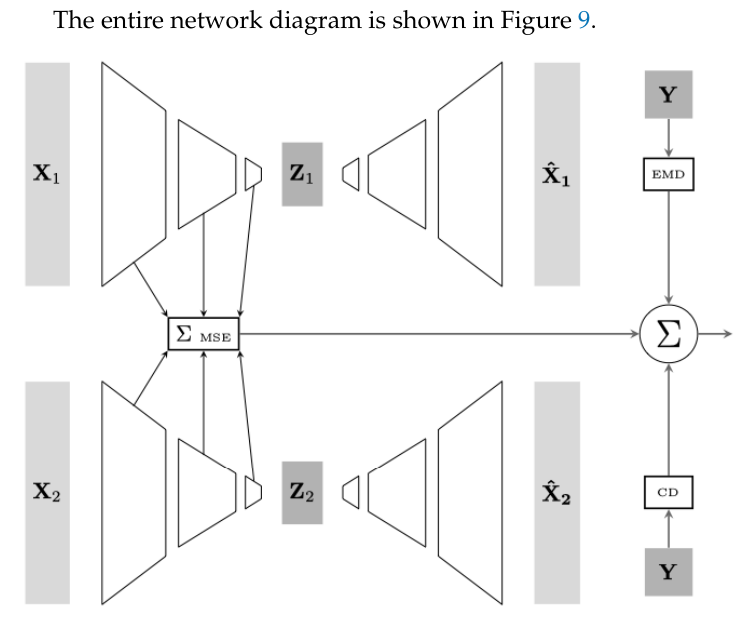
Figure 9. The proposed architecture is shown above. Loss is calculated between each feature layer, and we compare the feature layers using an MSE loss. This feature loss is added to the overall